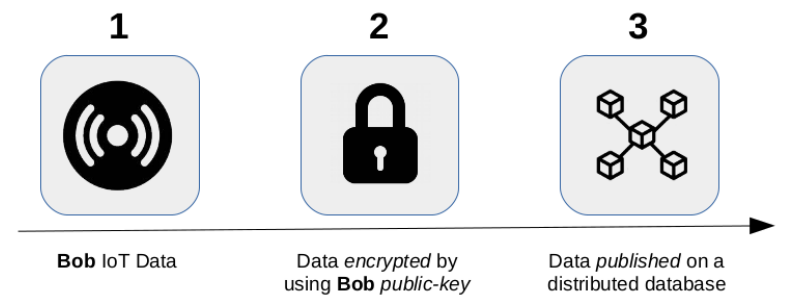
Figure 12. Data encryption